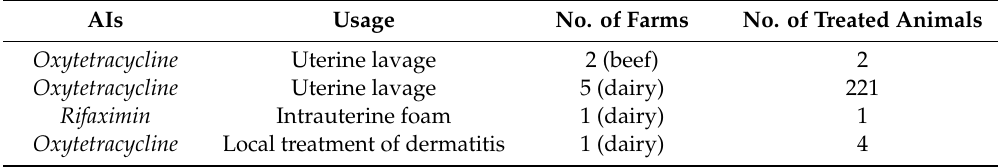
Table A6. Topical treatments excluded from DDD vet / DCD vet calculations (AI = active ingredient). AIs